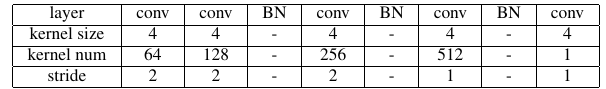
Table 4. Architecture of Discriminator D .